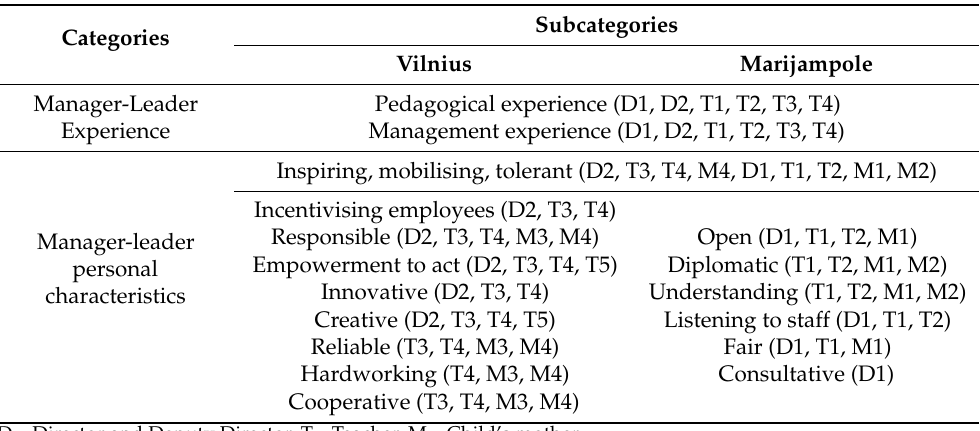
Table 3. Experiences of the personality traits of a manager-leader in